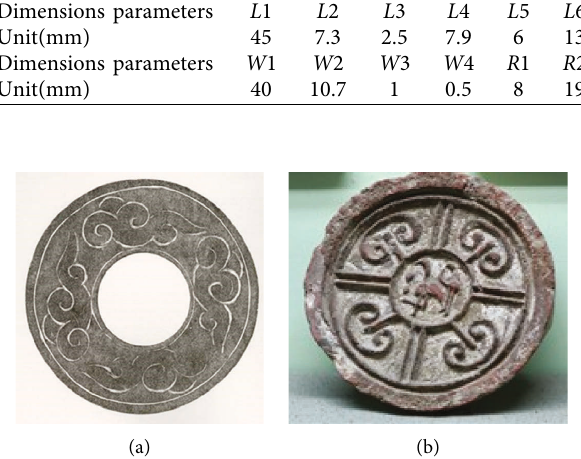
Figure 2: (a) Cloud pattern jade wall of the Tang dynasty. (b) Tile- end with rolling cloud design warring states